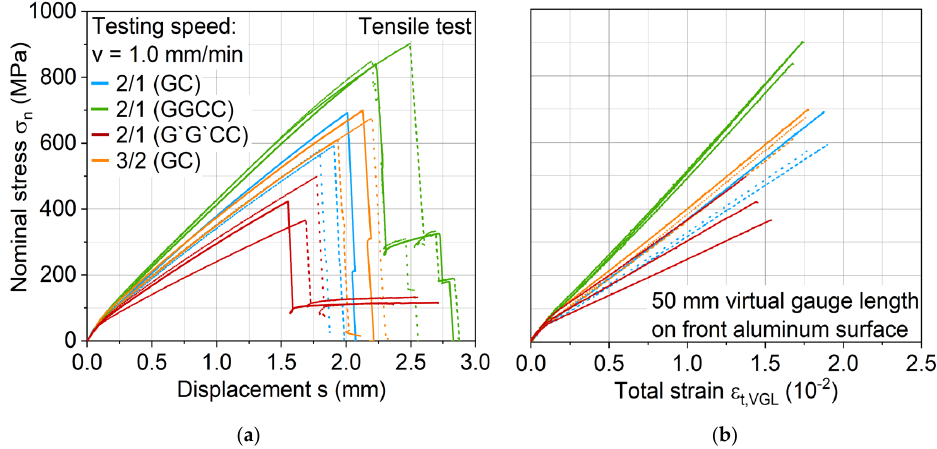
Figure 10. ( a ) Stress-displacement curves and ( b ) stress-strain curves of hybrid laminates with aluminium alloy AA6082-T4 and a graded structure of glass and carbon fibre-reinforced PA6 for different layer structures and metal volume contents.